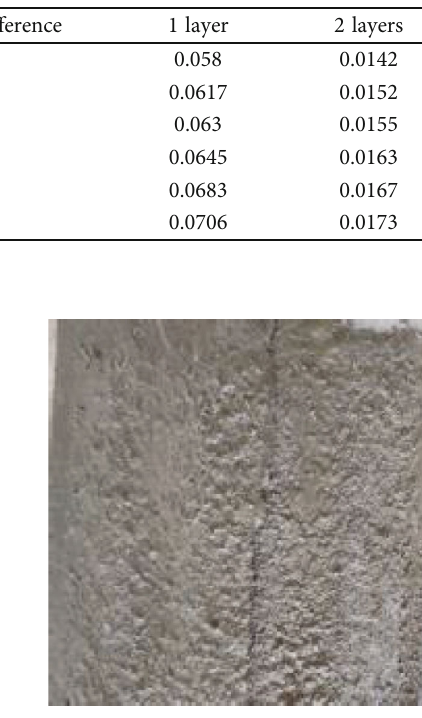
Table 3: Permeability coe ffi cient K of the slotted tube overlay geotextile after blocking.